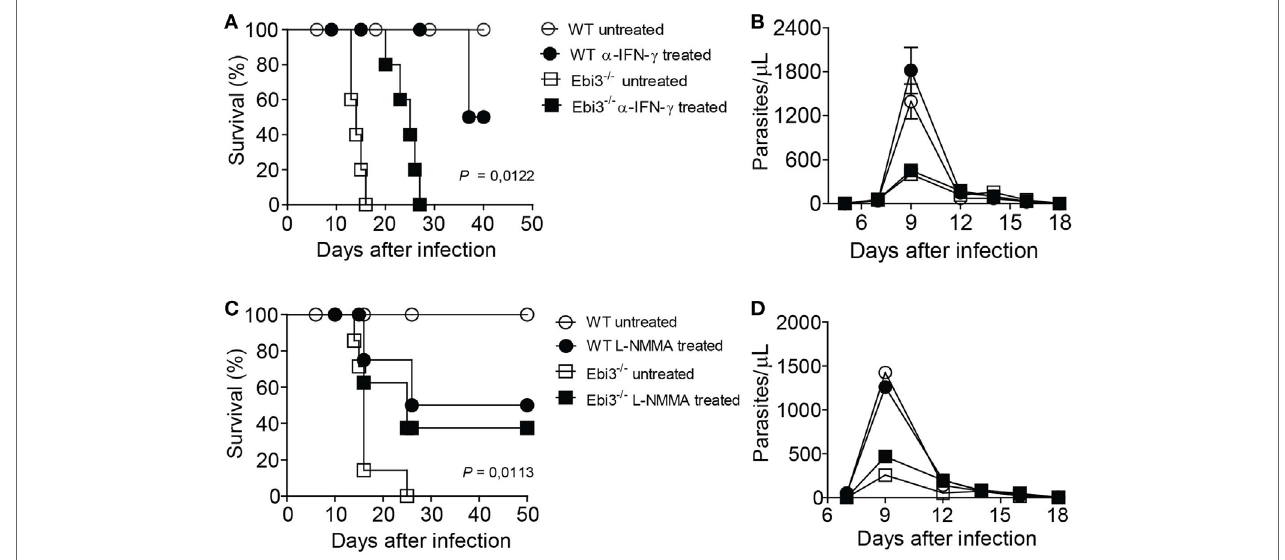
FigUre 8 | Blockade of IFN- γ or NOS prevents host susceptibility of Trypanosoma cruzi -infected Ebi3-deficient mice. (a–D) Ebi3-deficient or wild-type (WT) mice previously infected with T. cruzi were treated with α -IFN- γ at 9, 12, and 15 d.p.i. or L-NMMA at 9, 12, 15, and 18 d.p.i. intraperitoneally. (a,c) Mortality was daily evaluated and (B,D) bloodstream parasitemia was analyzed on alternate days from 5th until 18th day after infection. These data are representative of three independent experiments ( n = 5) and expressed as mean ± SEM ( P <